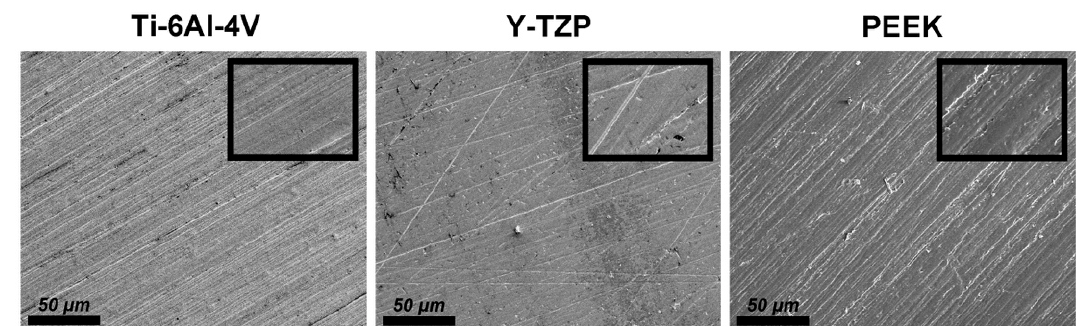
Figure 2. The FE-SEM surface morphologies of each dental materials: the scale bar is 50 μ m (magnifications of 500), and the width of the small, enlarged picture is equal to 2.5 μ m (magnifications of 2000).